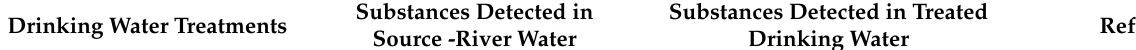
Table 1. Examples of the studies related to emerging microcontaminants in river and drinking